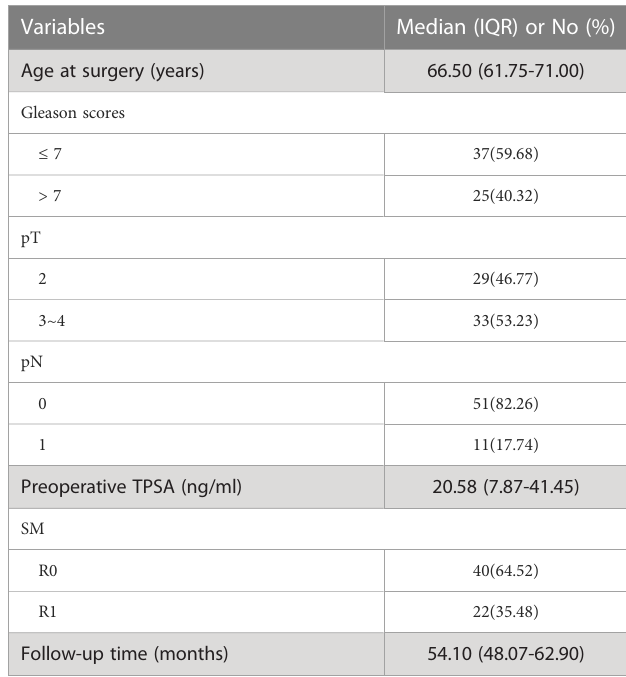
TABLE 1 Baseline characteristics of all patients